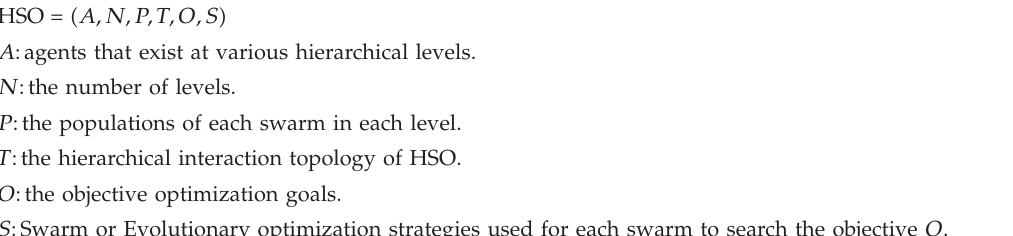
Table 1: The structure of HSO model.